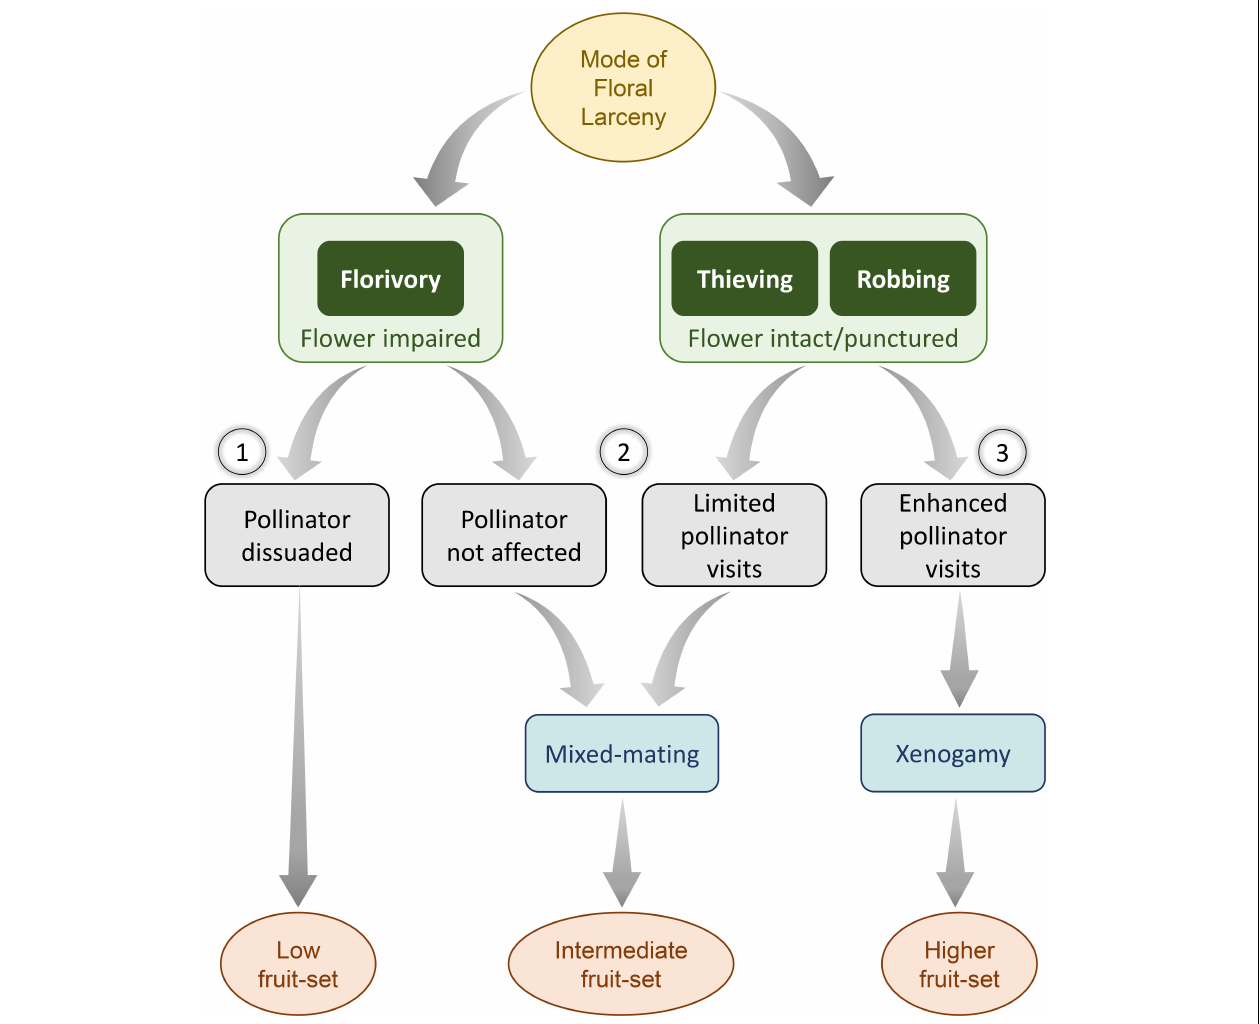
FIGURE 4 | A consequence of floral larceny on reproductive fitness among preferentially outbreeding plant taxa. In such taxa, fitness is largely driven by foraging guilds, the nature and extent of larceny, and the breeding strategy adopted by the plant. When a floral organ of functional significance is excised and pollinators are dissuaded, the fruit-set is likely to decline (1). In contrast, the plants may exercise a mixed-mating strategy to result in intermediate fruit-set either due to unaltered pollinator’s behavior or limited visits of pollinators (2). Alternatively, when the organ is intact (as seen during robbing or thieving), higher than usual fruit-set may be observed through increased pollinator visits in cross-pollinated plants